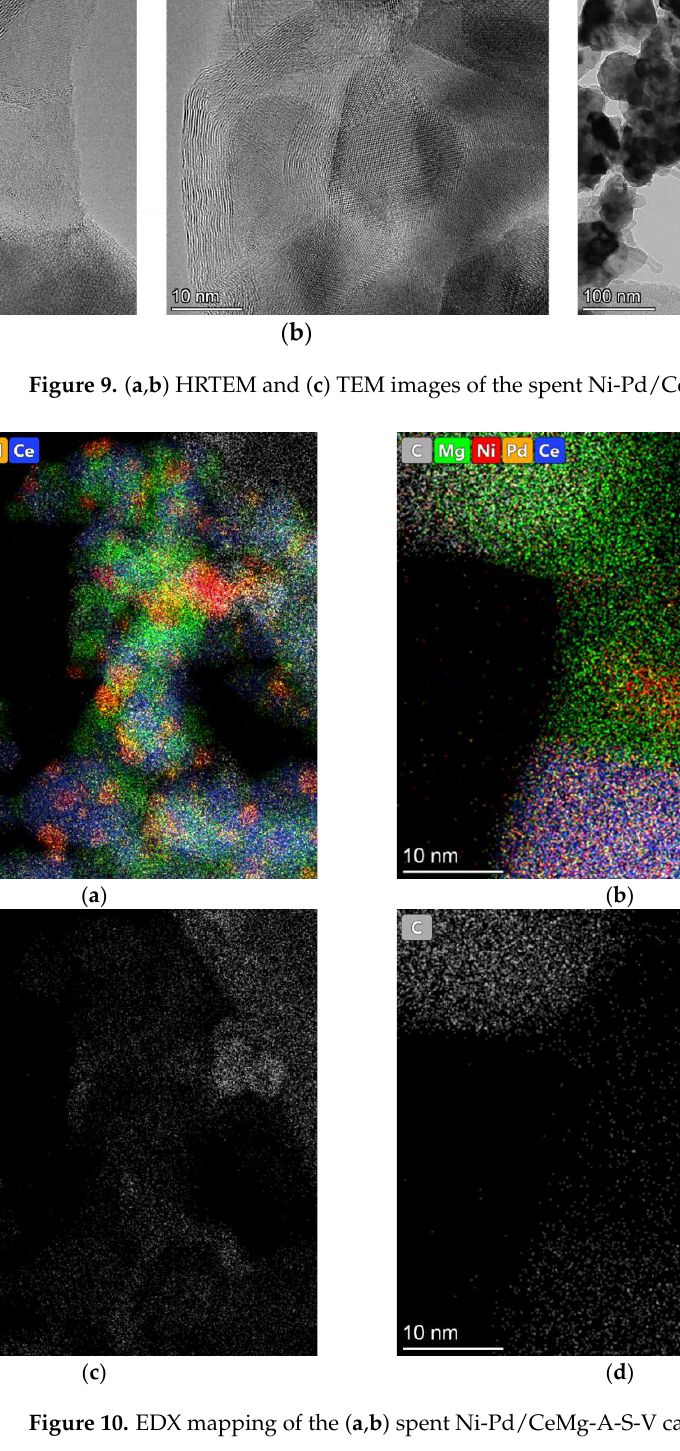
Figure 10. EDX mapping of the ( a , b ) spent Ni-Pd/CeMg-A-S-V catalysts, ( c , d ) C elemental map.